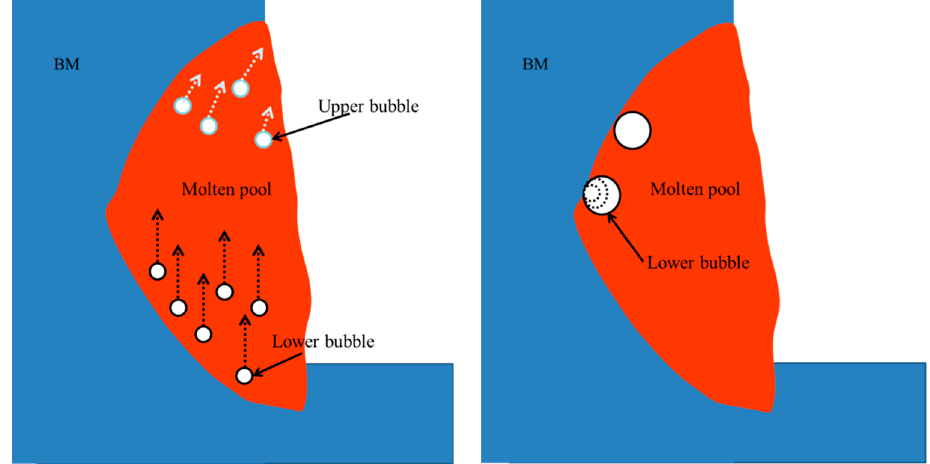
Figure 11. Pore-forming mechanism at incomplete penetration.